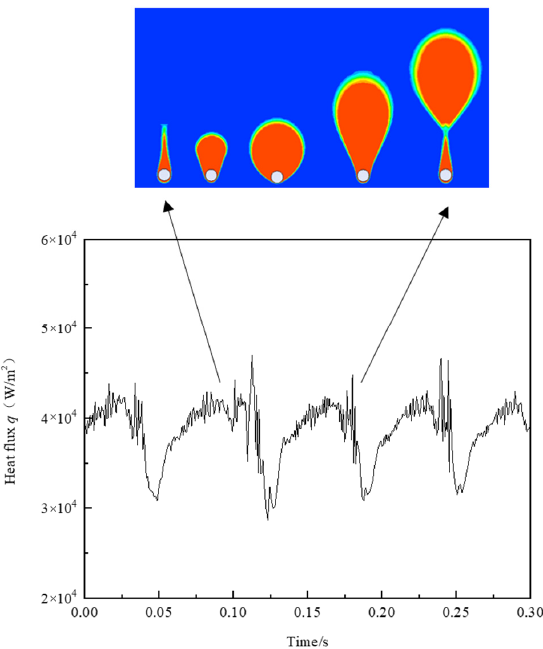
Figure 8. The spatial-averaged heat flux and the evolution of bubbles for the 0.5 mm wire.